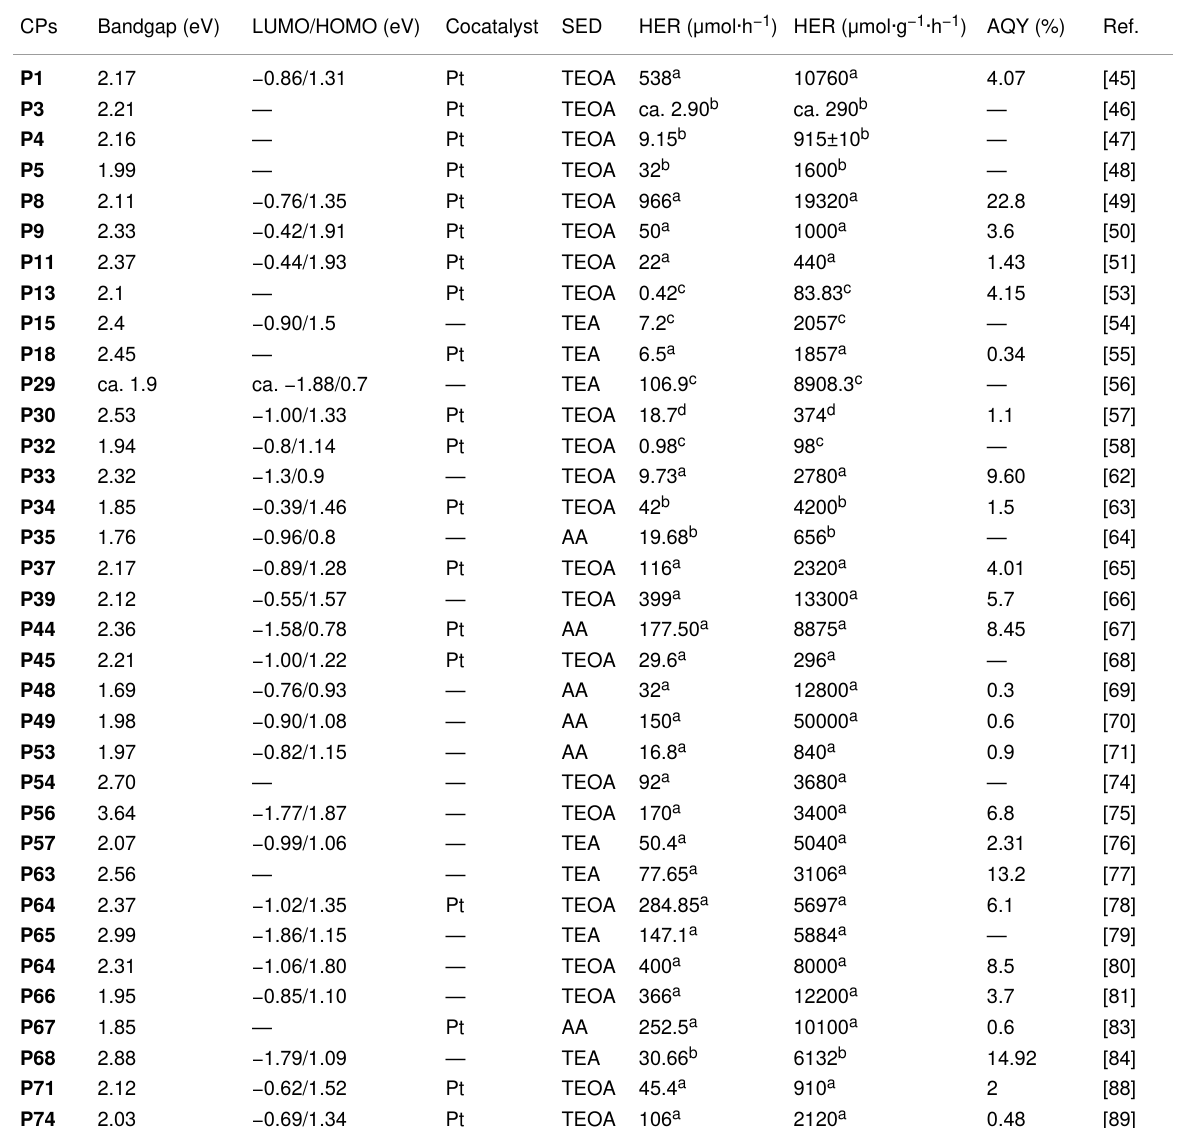
Table 1: Summary of the bandgaps, cocatalysts, and properties related to H 2 evolution of quintessential CP photocatalysts.